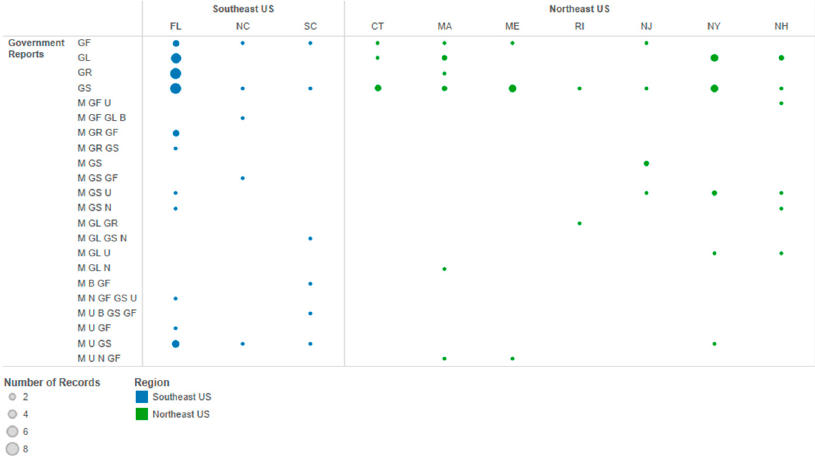
Figure 7. Multiple scales of government reports by state in four categories and eight subcategories from mixed sources. GF: government federal, GS: government state; GR: government regional; GL: government local. M: mixed-source